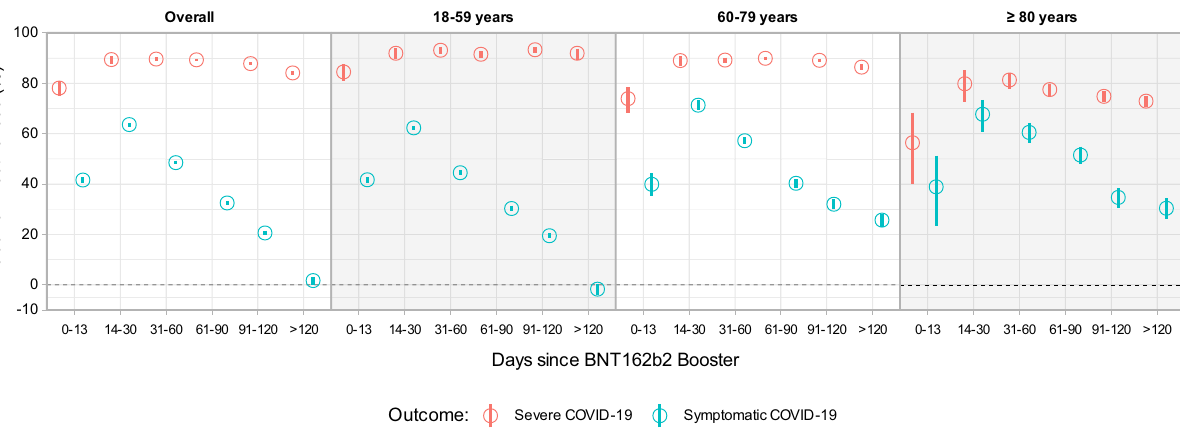
Fig. 3 Vaccine Effectiveness against symptomatic and Severe COVID-19. According to days after booster dose during the Omicron dominance period, strati fi ed by age group. Point estimates are adjusted vaccine effectiveness (1- adjusted odds ratio), with error bars indicating the corresponding 95% Wald ’ s C.I. Blue represents adjusted VE against symptomatic infection, and red adjusted VE against severe outcomes. All models the comparison group